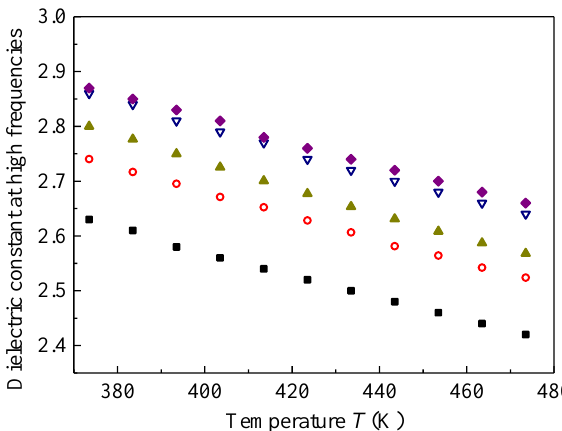
Figure 6. Dielectric constant at high frequencies above 10 3 Hz ε r ∞ as a function of measurement temperature T . : Pristine, : irradiated at 145 °C for 900 h, : irradiated at 145 °C for 1500 h, : irradiated at 185 °C for 900 h, : irradiated at 185 °C for 1500 h.